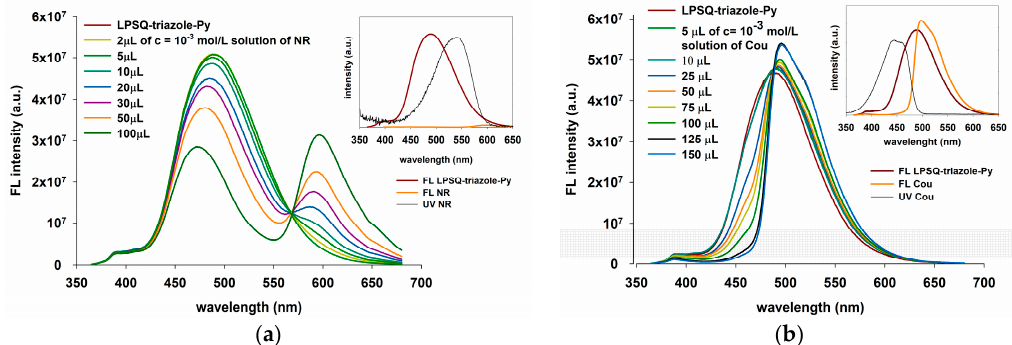
Figure 14. Energy transfer from LPSQ-triazole-Py to ( a ) Nile Red and ( b ) Coumarin 6 (insets: spectral overlap of LPSQ derivatives and dyes; measurements carried out as described in Materials and Methods).